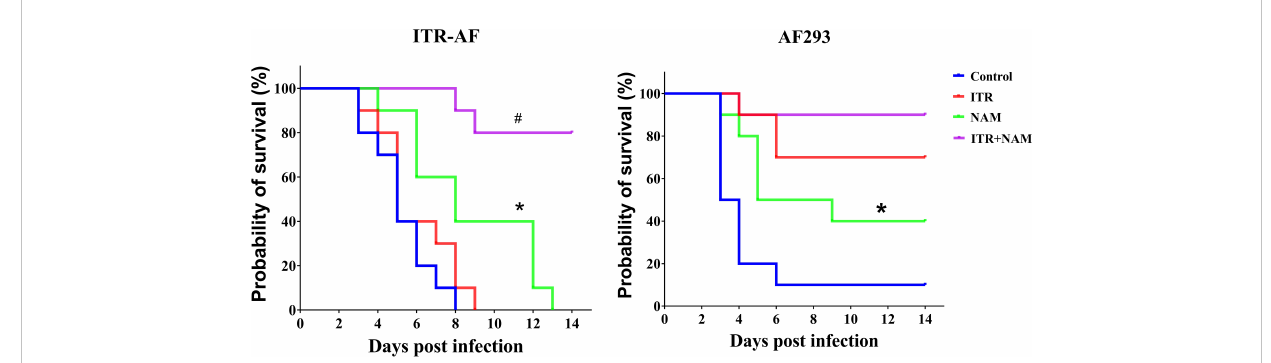
FIGURE 5 Survival curves of mice infected with the triazole-sensitive strain AF293 and triazole-resistant strain ITR-AF. Mice infected with A. fumigatus were treated with ITR (25 mg/kg orally twice a day) alone or in combination with NAM (500 mg/kg intraperitoneally daily). ITR, itraconazole; NAM,